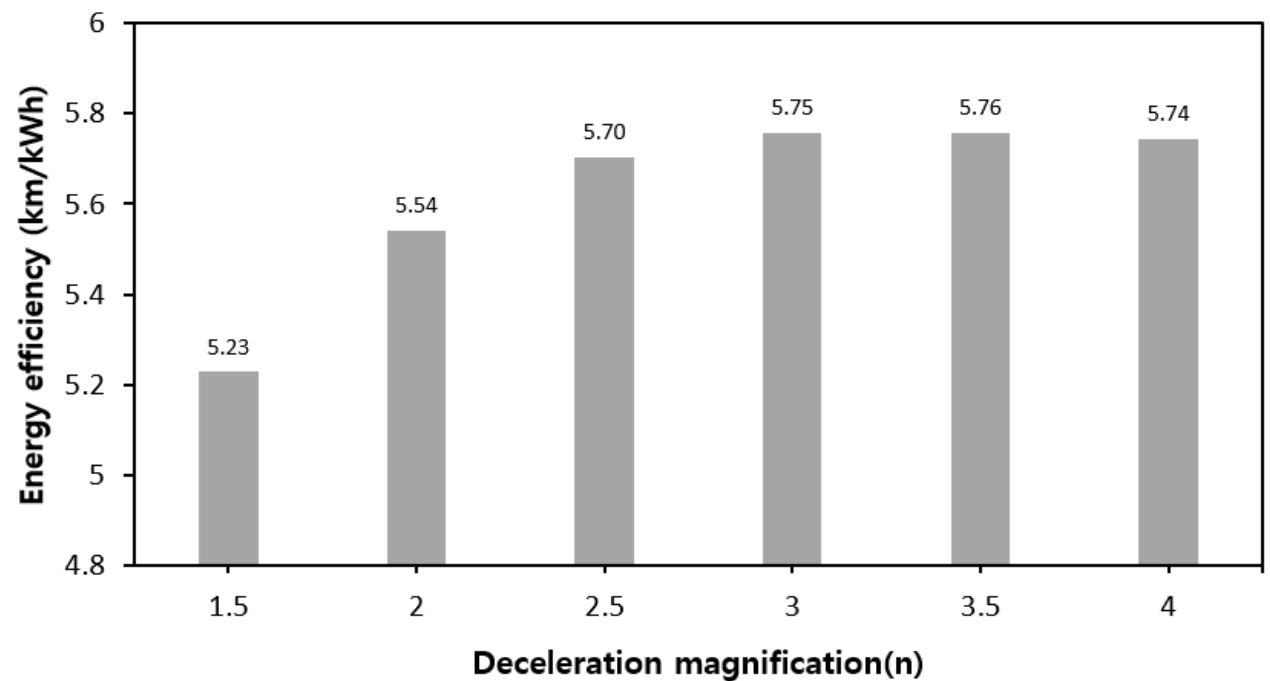
Figure 12. Comparison of energy efficiency according to deceleration ratio.